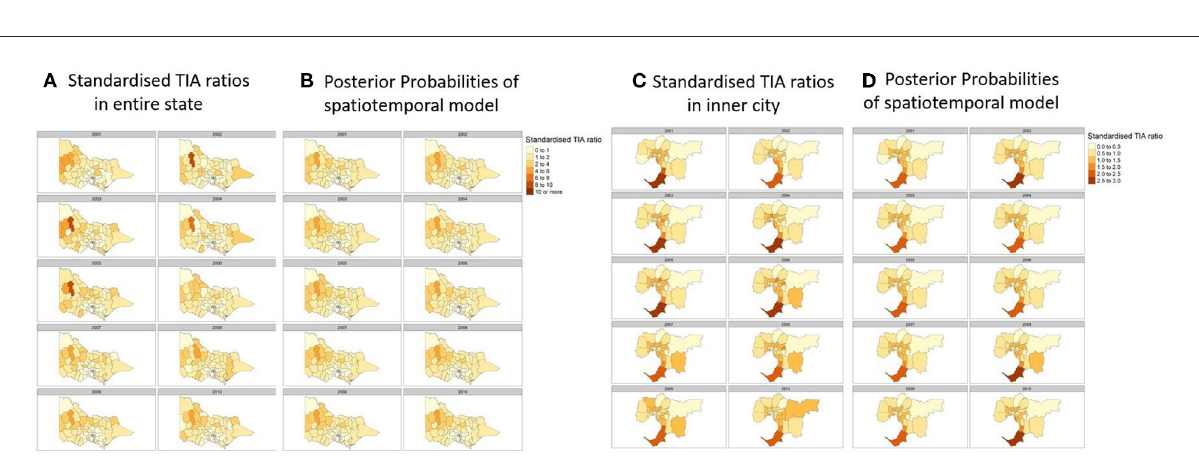
FIGURE3 (A) Actual Standardized TIA Ratios measured each year in the state. (B) Posterior probabilites of the best performing spatiotemporal model utilizing a spatial lag component and temporal component of random walk order of one. (C) Actual Standardized TIA Ratios measured each year in the inner cities of the state. (D) Posterior probabilites of the best performing spatiotemporal model utilizing a spatial lag component and temporal component of random walk order of one. Covariates used in the regression were hypertension, sex, and population count, proportion of population above 60 and SES decile according to the Index of Relative Socioeconomic Advantage and Disadvantaged